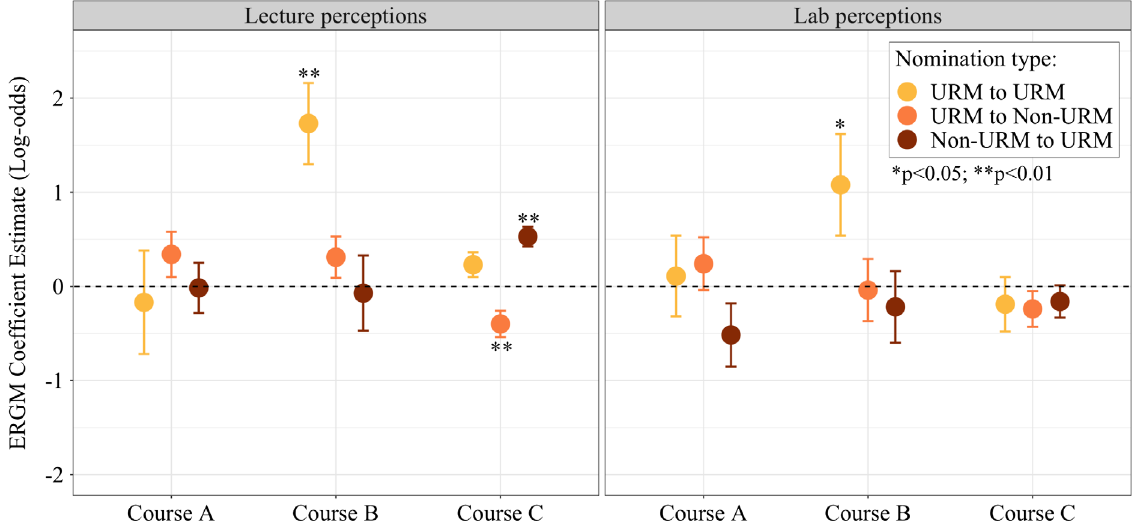
FIG. 4. ERGM coefficient estimates for the race or ethnicity nomination variables. The base term (i.e., coefficient estimate of zero) is nominations from non-URM to non-URM. Error bars are the standard errors of the coefficient estimates (values shown in Table IV) and asterisks indicate